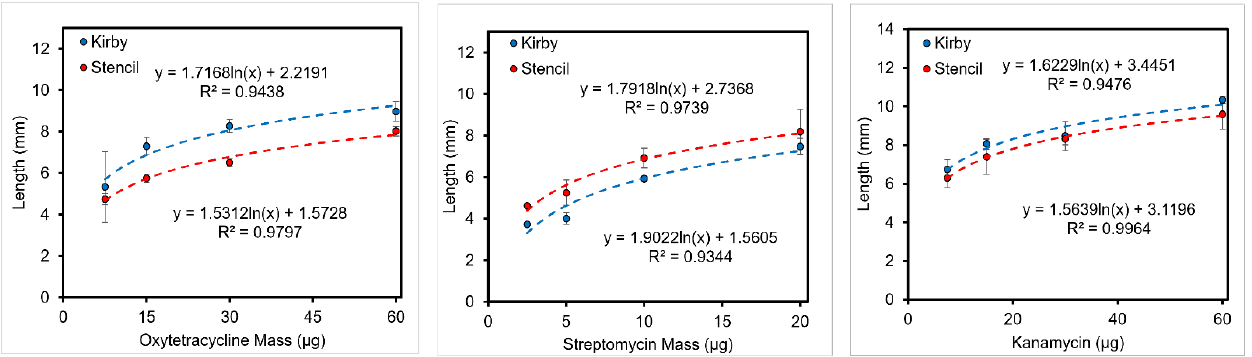
Figure 10. E. coli K-12 Antibiotic Resistance Test. ( Left ) Oxytetracycline, ( Center ) Streptomycin, ( Right ) Kanamycin.